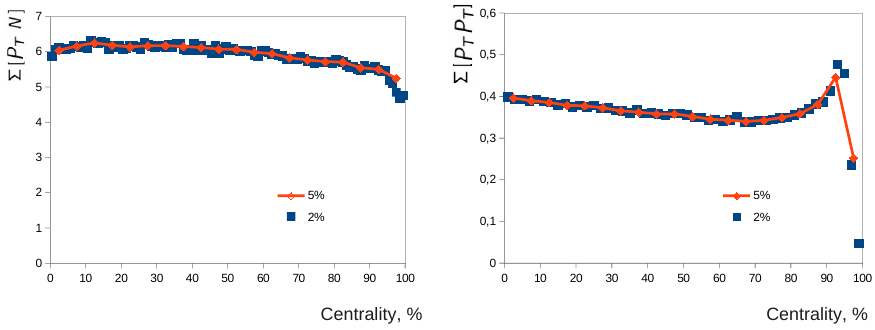
Figure 3. Strongly intensive quantities Σ P lated in the Monte Carlo model with string fusion for Pb-Pb collisions at 2.76 TeV. As in Fig. 2, two centrality class binning (2% and 5%) are shown by di ff erent